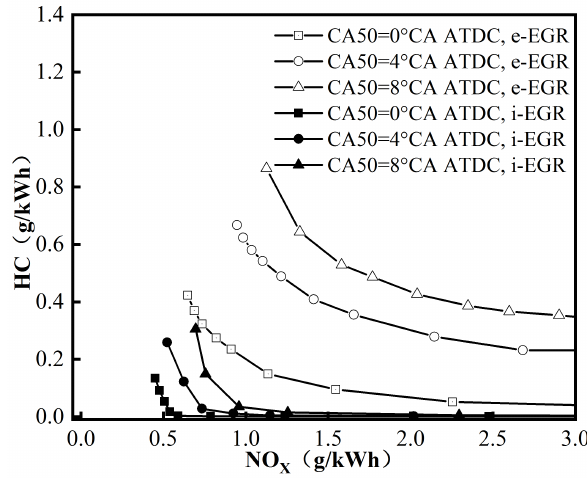
Fig. 12 Effects of CA50 and EGR ratio on the HC emission.